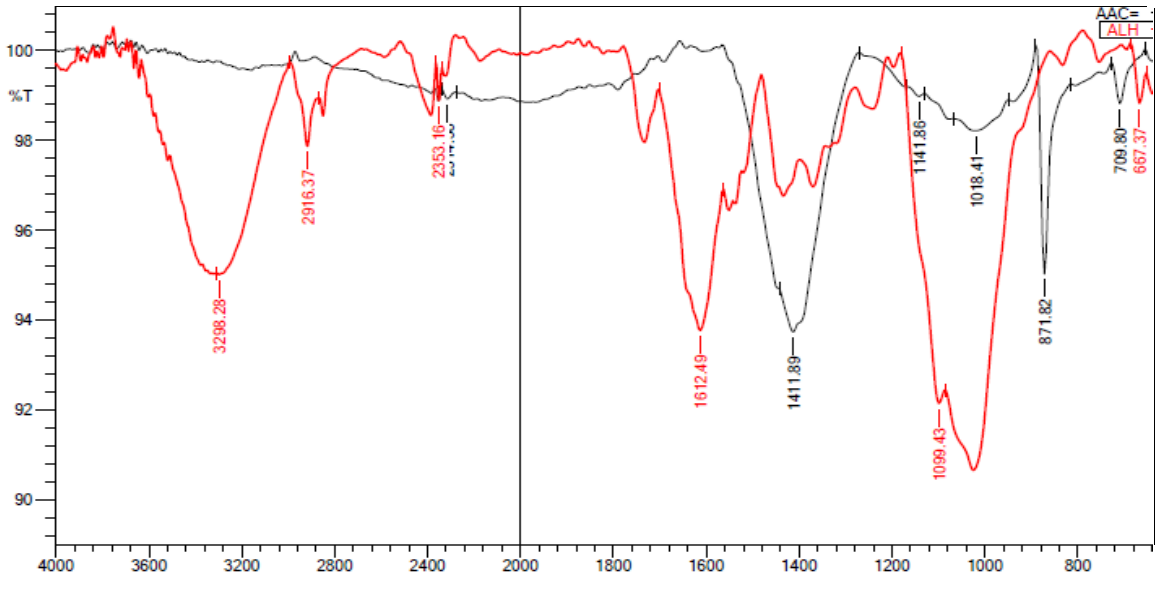
3.2 Yield of activated carbons.